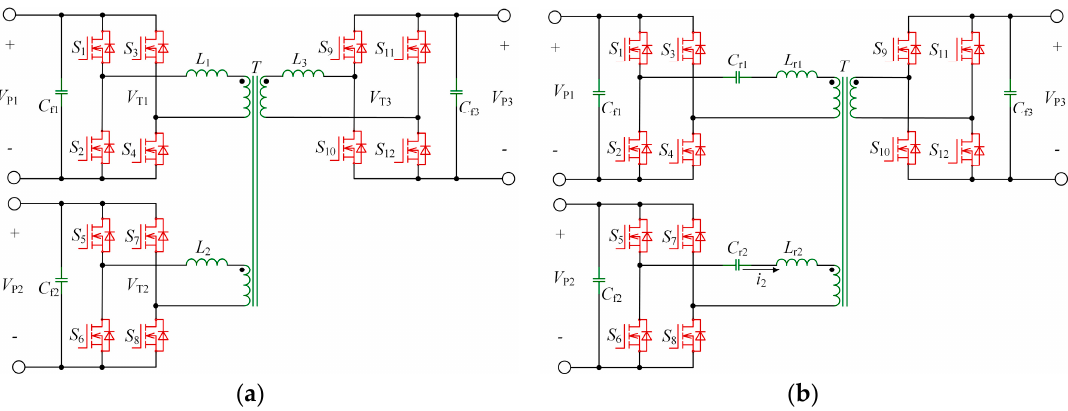
Figure 1. Topology of the isolated TP-BDCs: ( a ) TAB; ( b ) TP-SR-BDC.